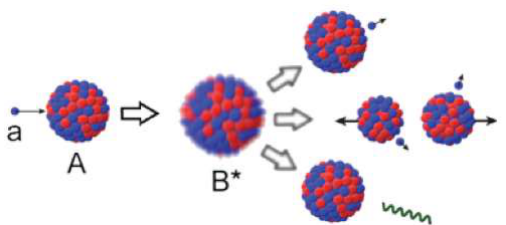
Figure 1. Illustration of a nuclear reaction proceeding through the compound nucleus stage. Here the projectile a collides with A to form B ∗ , which then decays to a number of possible prod- ucts. Image taken from Ref.